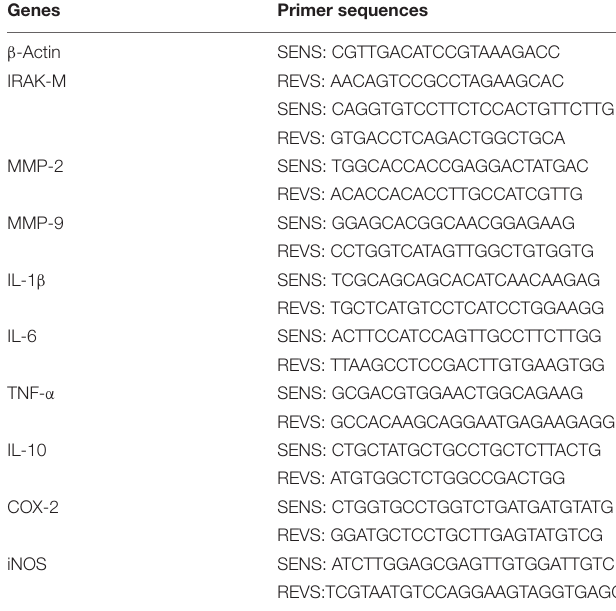
TABLE 2 | Primers used for real-time